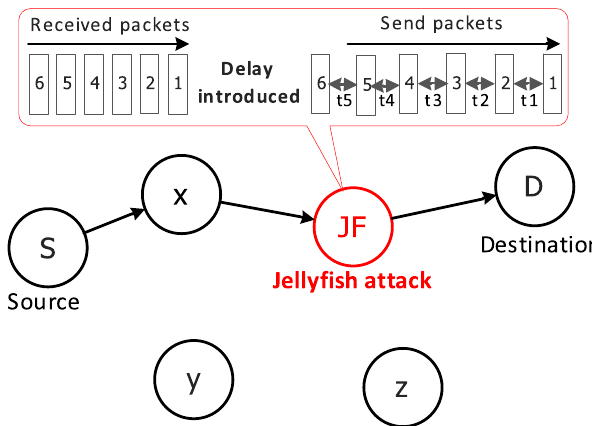
Figure 3. Jellyfish delay variance attack.